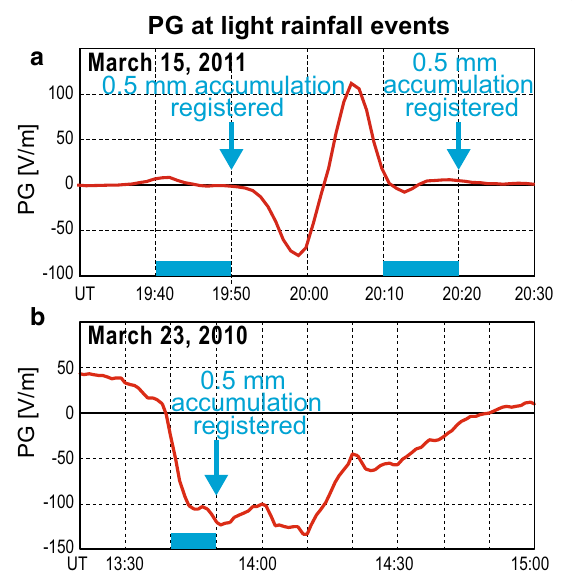
Fig. 2 One-minute averaged values of PG around isolated light rain (0.5 mm in 10-min accumulation) on a March 15, 2011, and b March 23, 2010. Horizontal blue lines and vertical blue arrows denote the rain periods and the registration timing of the accumulation